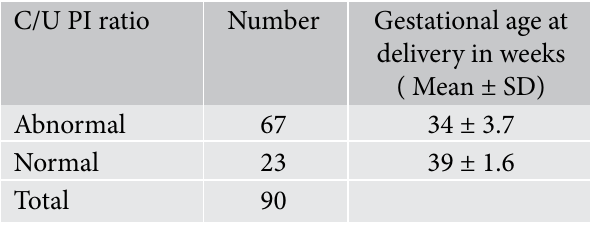
Table V: Sensitivity, specificity, accuracy, positive